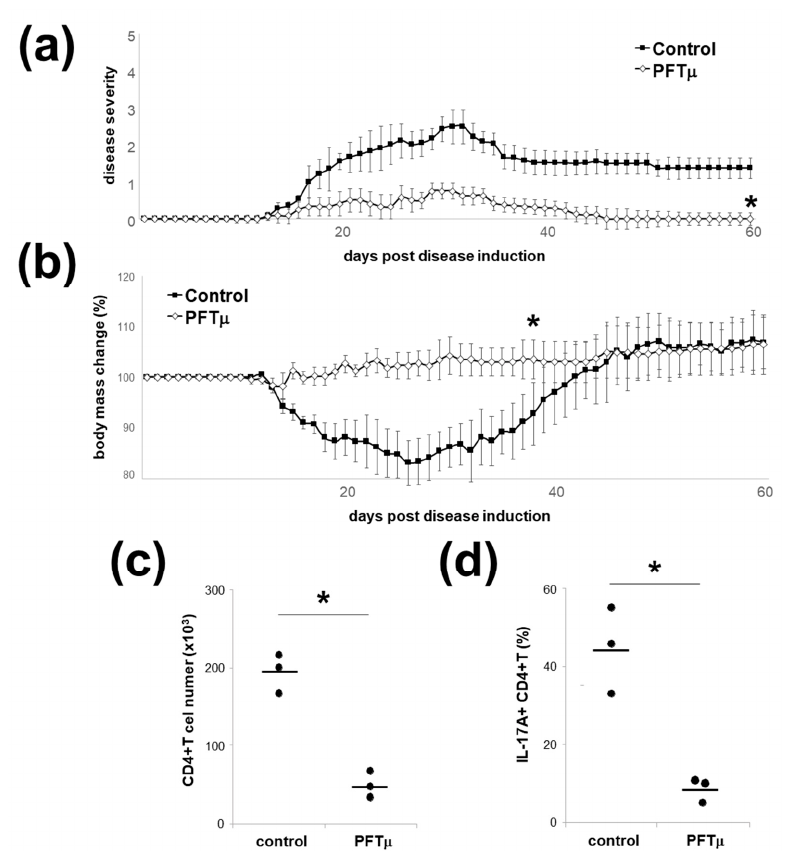
Figure 6. PFT µ in vivo ameliorates experimental autoimmune encephalomyelitis (EAE). ( a ) Clinical scores or ( b ) body mass changes of the mice with EAE that have been treated with PFT µ i.p. on day 0, 2, 4, 6 and 8, or a control (DMSO) are presented (mean ± SEM). Five mice per group were used. * p < 0.05, Mann–Whitney U test. ( c ) Quantification of CNS-infiltrating CD4 + T cells in PFT µ mice with EAE at 15